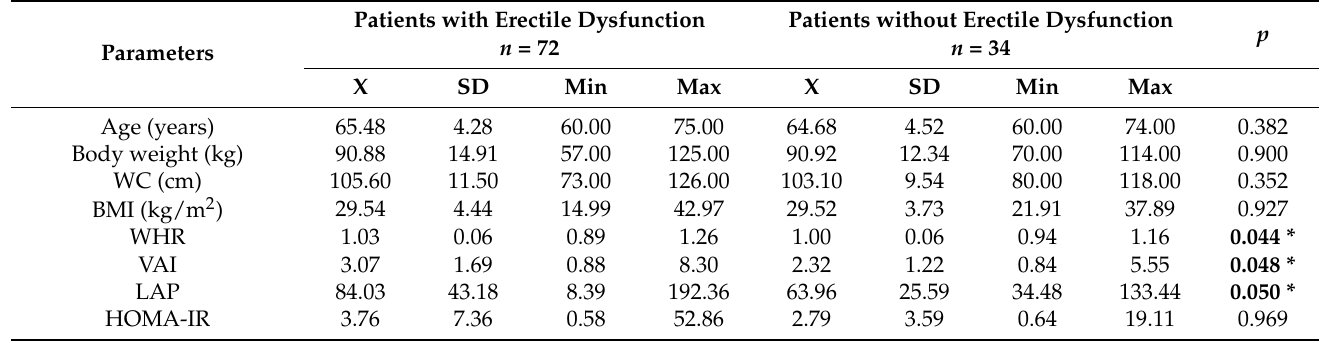
Table 1. Analysis of the relationship between anthropometric parameters in men depending on the score obtained in the International Index of Erectile